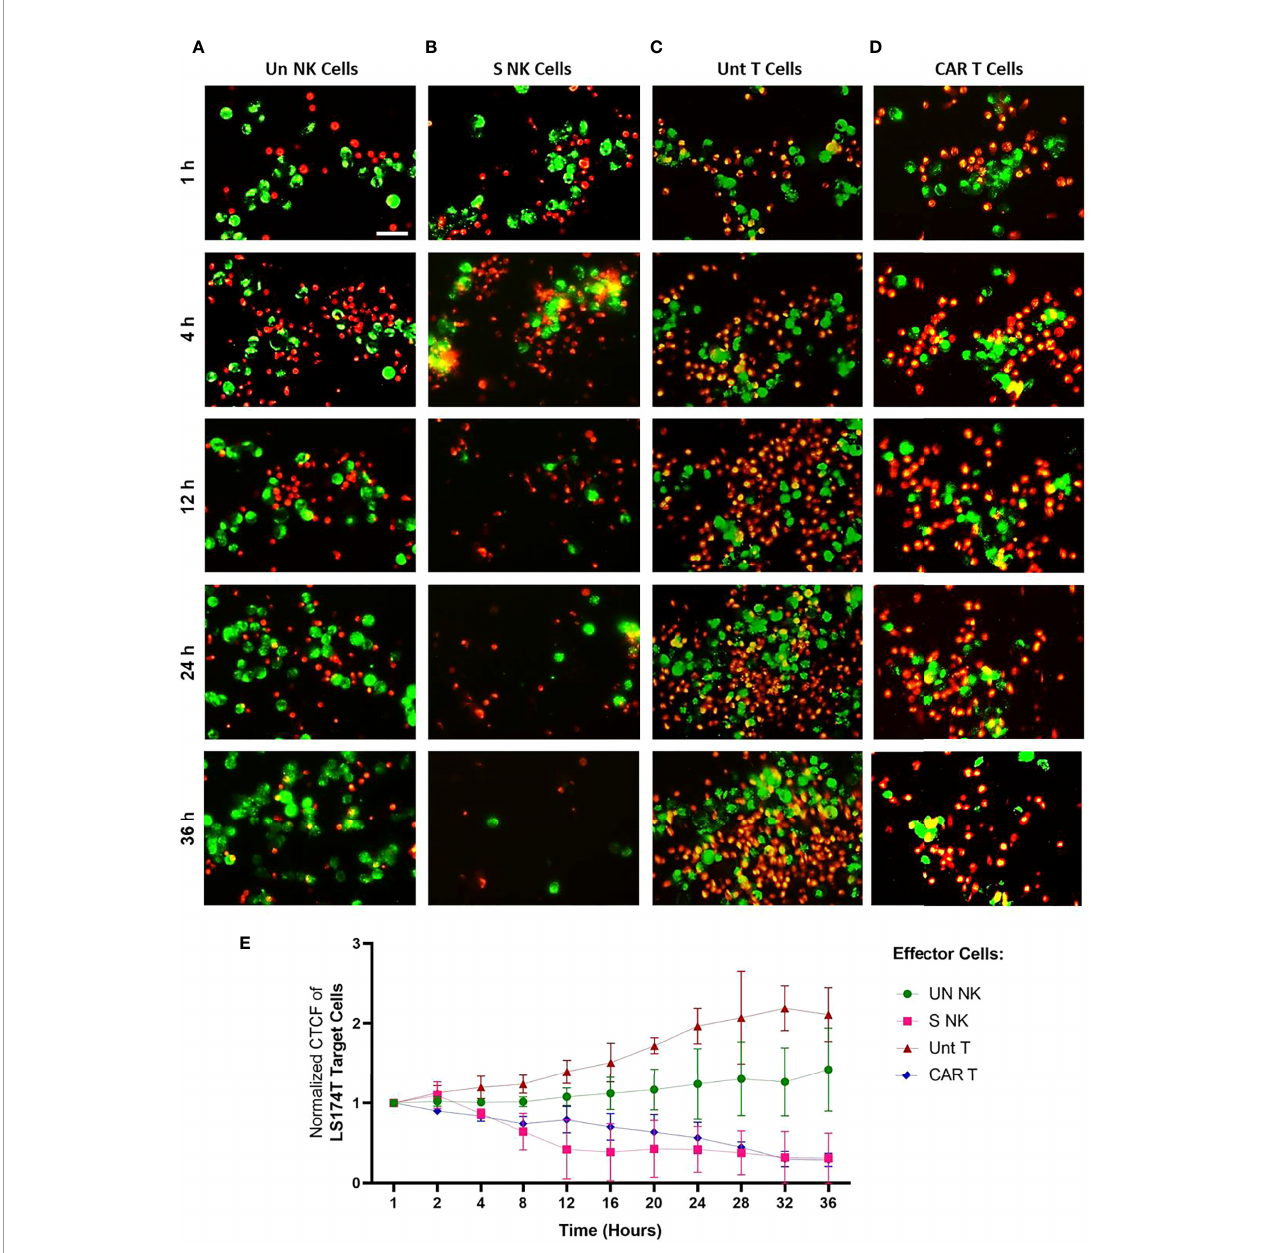
FIGURE 5 | Time-lapse visualization of effector cell - target cell interactions in vitro using live microscopy. The interaction of effector cells against Hsp70 high LS174T target cells was monitored over 36 hours using time-lapse imaging. (A) Unstimulated (Un) NK cells, (B) TKD/IL-2 stimulated (S) NK cells within PBMC preparations, (C) Untransduced (Unt) T cells, (D) Transduced anti-Hsp70 CAR T cells. Effector and target cells were fl uorescently stained with PKH26 (red) and PKH67 (green), respectively and co-cultured at a ratio of 2.5:1 per well of a 24-well plate. The experiment was started after adding the cells to the culture. Representative images at indicated time points (1, 4, 12, 24, and 36 hours) were provided for parallel comparison. The scale bar is 50 µm. The time-lapse images for each group are presented at various over 36 hours in Figures S5 – S8 . (E) The corrected total cell fl uorescence (CTCF) at the following time points (1, 2, 4, 8, 12, 16, 20, 24, 28, 32, and 36 hours) was calculated as described in methods (section 2.10). The data were normalized to the time point 1 hour and presented as the mean of three independent microscopic fi elds ±